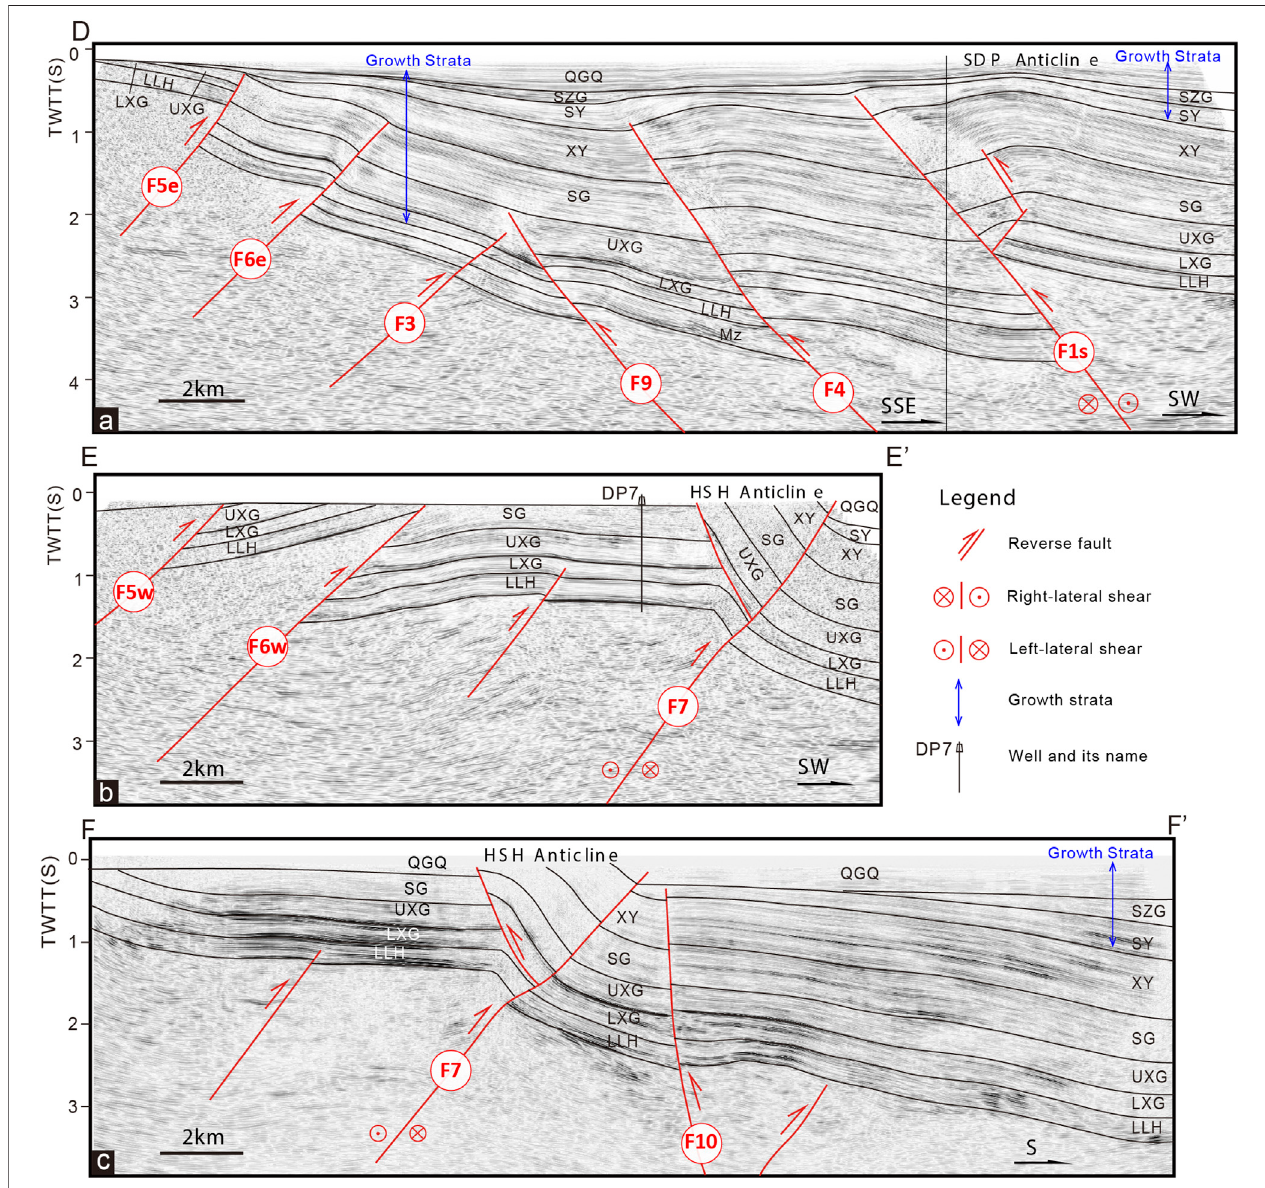
FIGURE5| Threeadditional seismic re fl ection sections acrossmajorfaultsinthe studyregion. Thelocation isshownin Figure 3 .Abbreviationsaresame asthose in Figure 4 .